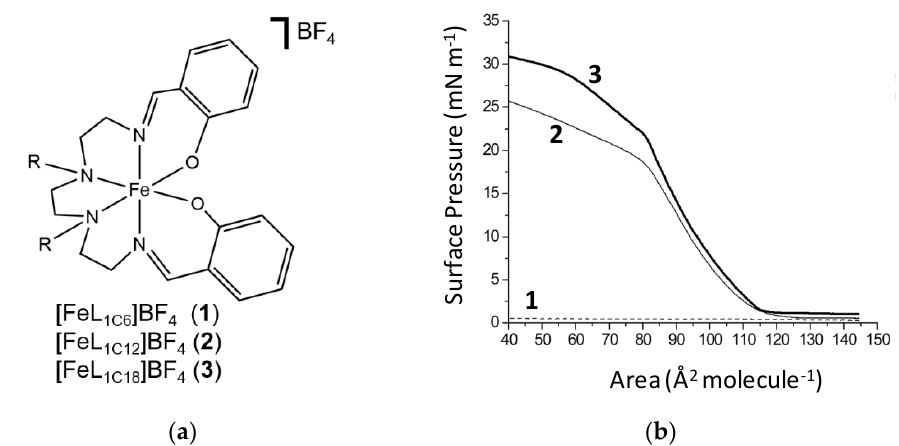
Figure 1. Schematic structure of 1 – 3 ( a ) and pressure-area isotherms for complexes 1 – 3 showing chain length dependence ( b ).